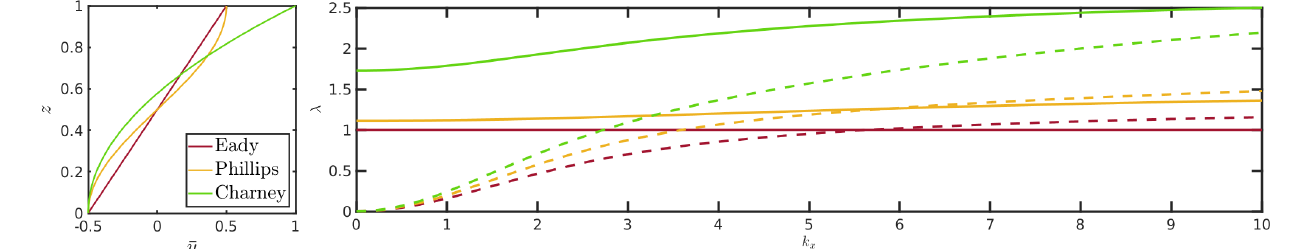
Figure 2. Left : Vertical profiles of mean flow ¯ u ( z ) for the three configurations (63)–(65). Right : Conversion (dashed) and production (solid) rates per unit energy as a function of k x for k y = 0 for all three mean flow configurations. Green: Charney; Red: Eady; Yellow: Phillips. The hori- zontal wavenumber k x is nondimensionalized using f / ( NH ) .